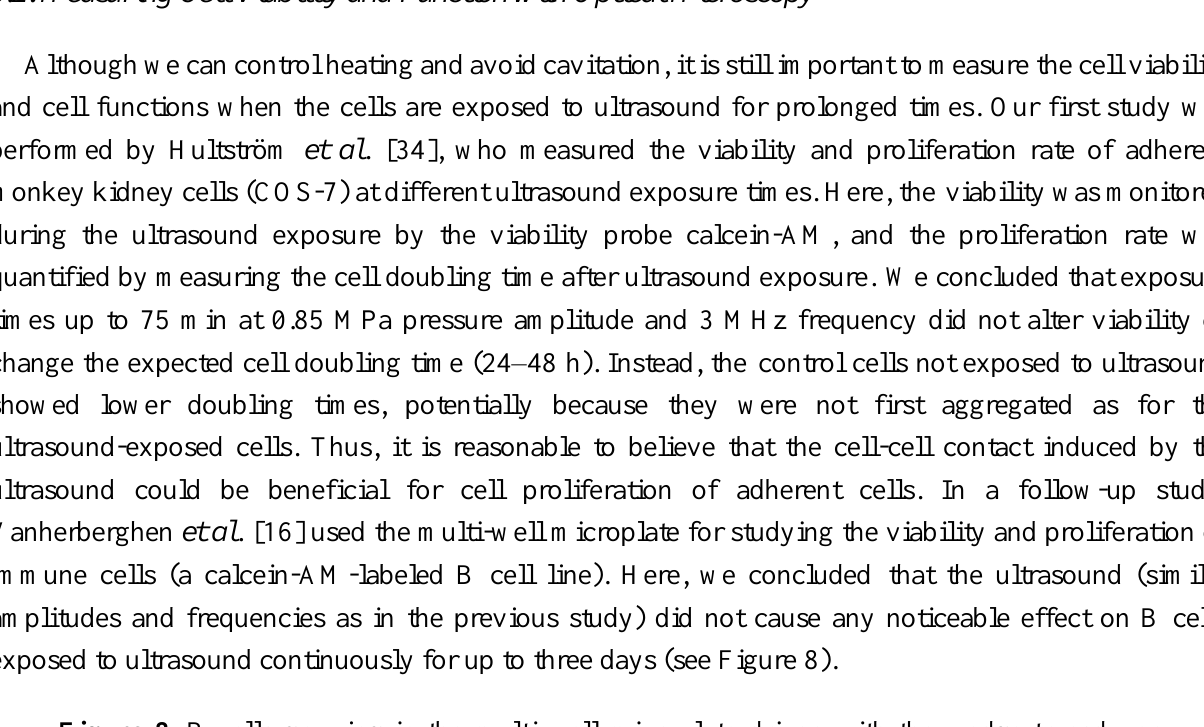
Figure 8. B cells growing in the multi-well microplate driven with the wedge transducer continuously at 10 V , 2.5 MHz (frequency modulation) for 60 h. The figure is based on pp results presented in Ref.